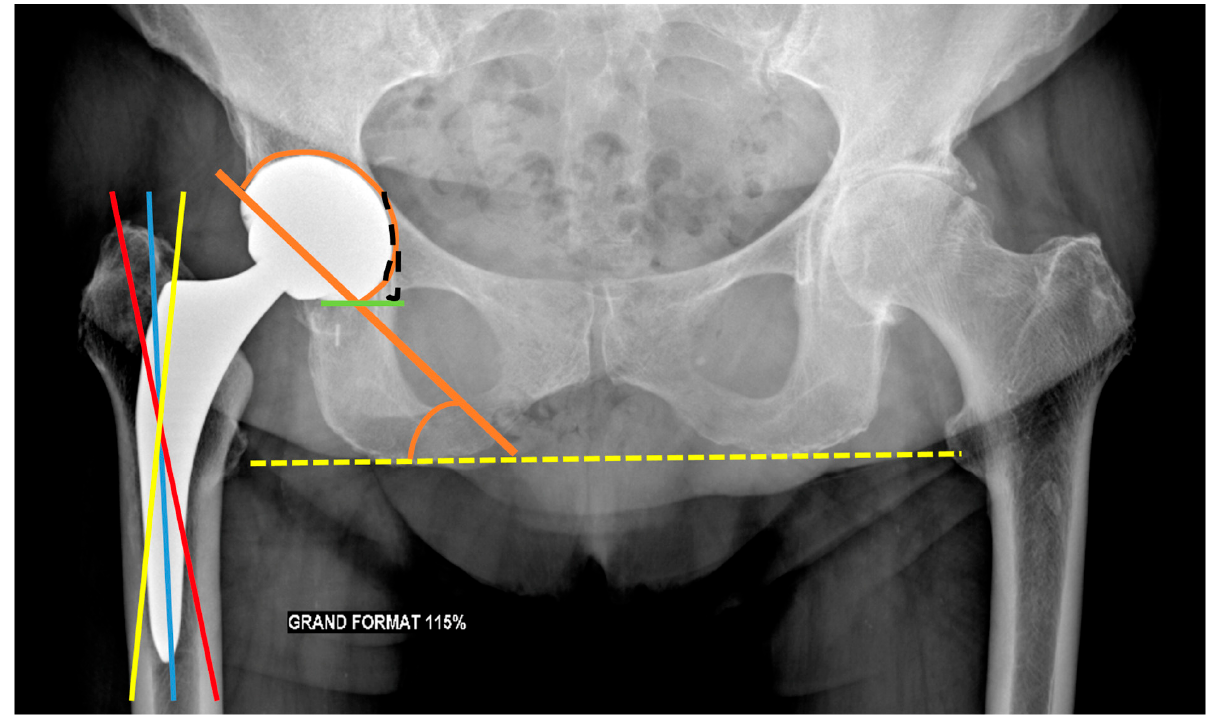
Figure 7. Acetabular frontal inclination and femoral stem position. Pelvic anteroposterior radiograph. The acetabular inclination corresponds to the orange angle between the acetabular piece contour (orange circle) and the transichiatic line (dotted yellow line). Additionally, note that the acetabular piece is aligned (green line) with the bottom of teardrop shadow (dotted black curve). The femoral stem should be placed in a neutral position (blue line). A slight valgus (red line) can be tolerated, but varus (yellow line) should not occur.